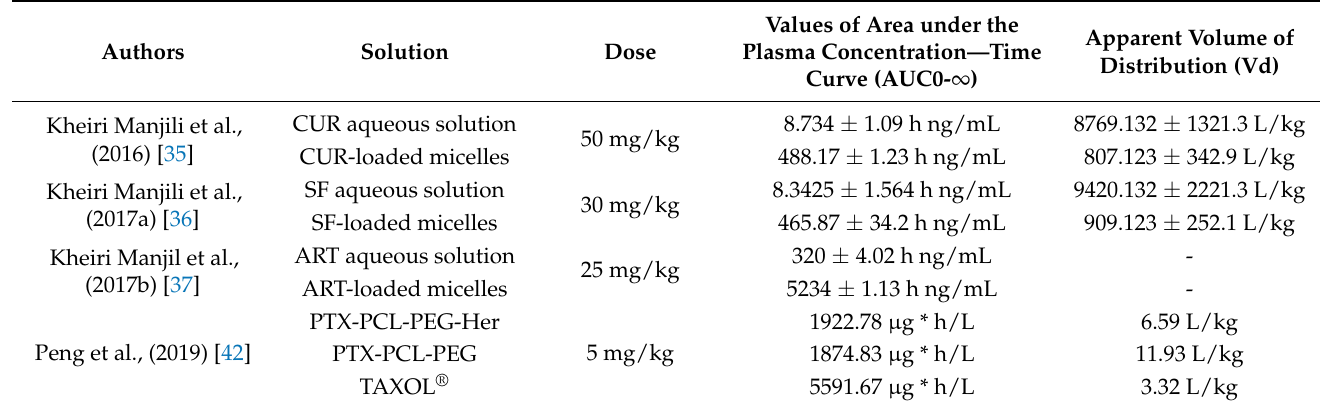
Table 8. Pharmacokinetic study of drug-loaded PCL-PEG copolymeric